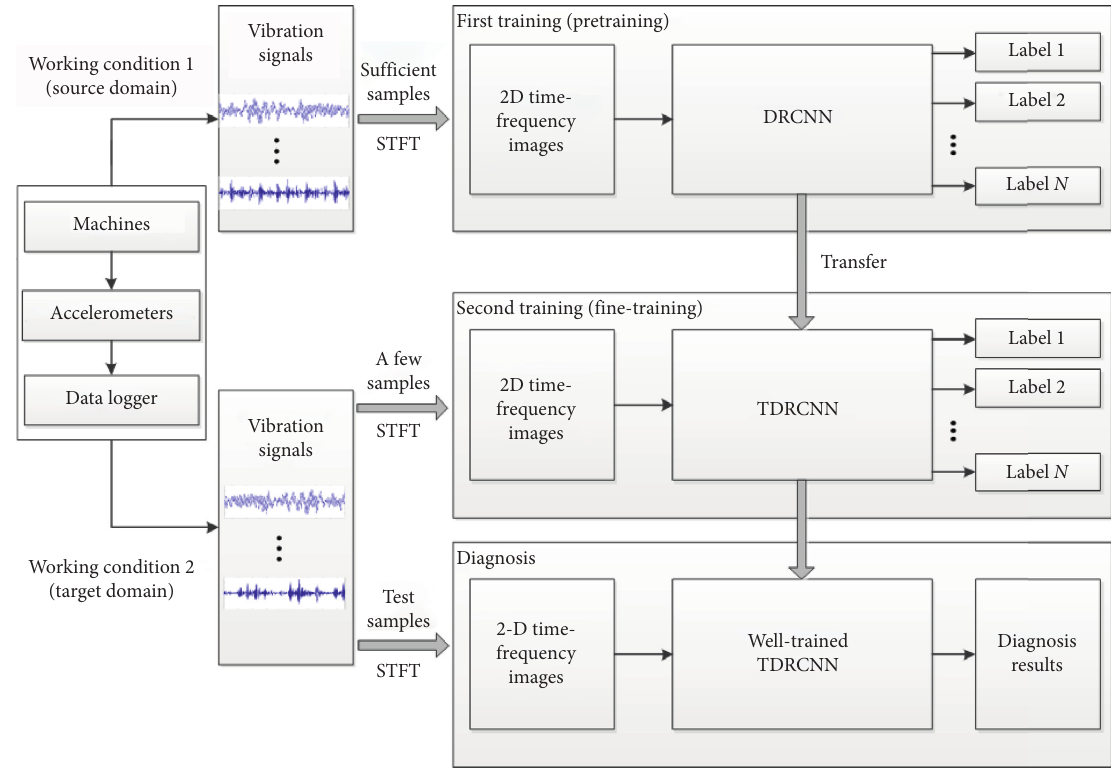
Figure 1: Framework of the proposed